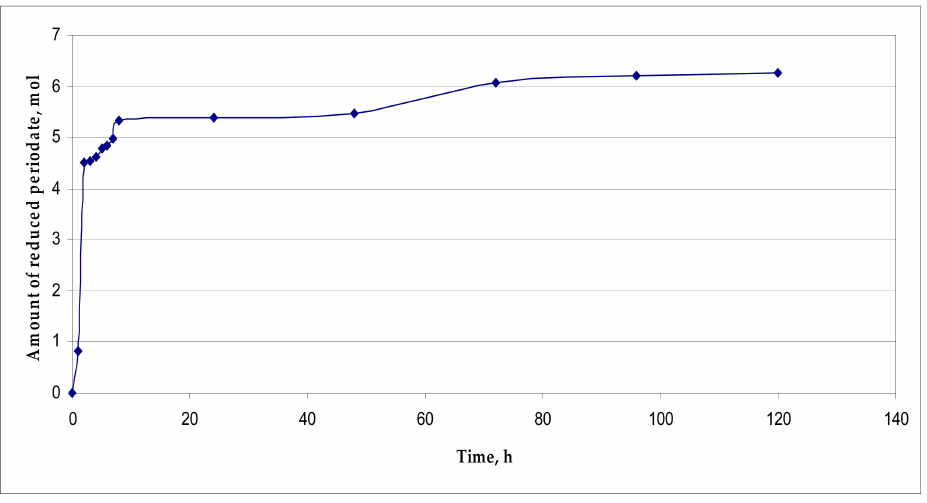
Figure 3. Consumption of NaIO 4